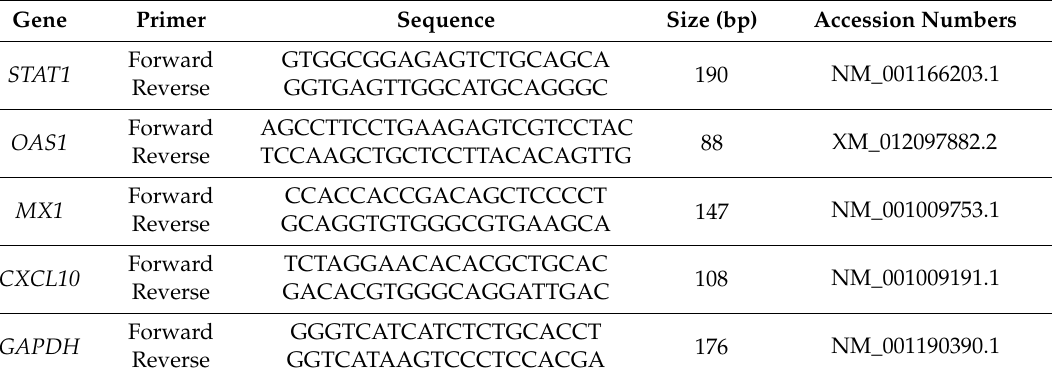
Table 1. Primers used for